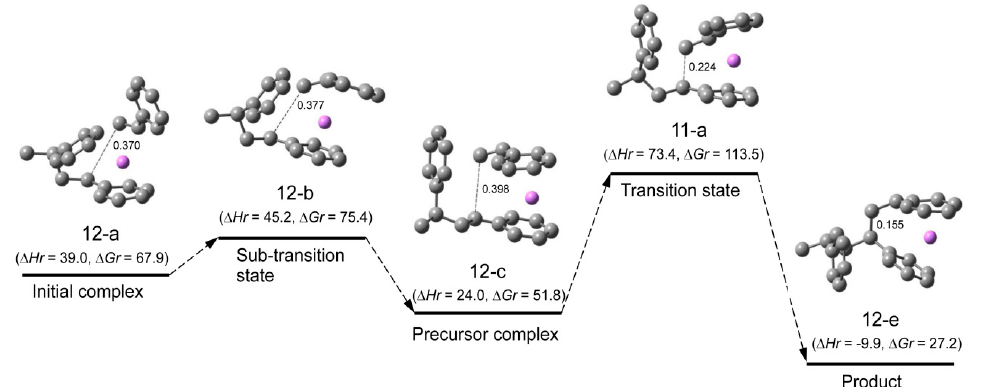
penultimate unit coordination of HSt 2 Li(10-c). However, the true activation energy for the former is much higher than that for the latter because of the steric hindrance caused by the close access of the penultimate styrene unit to the adjacent chain-end unit and styrene at the transition state.